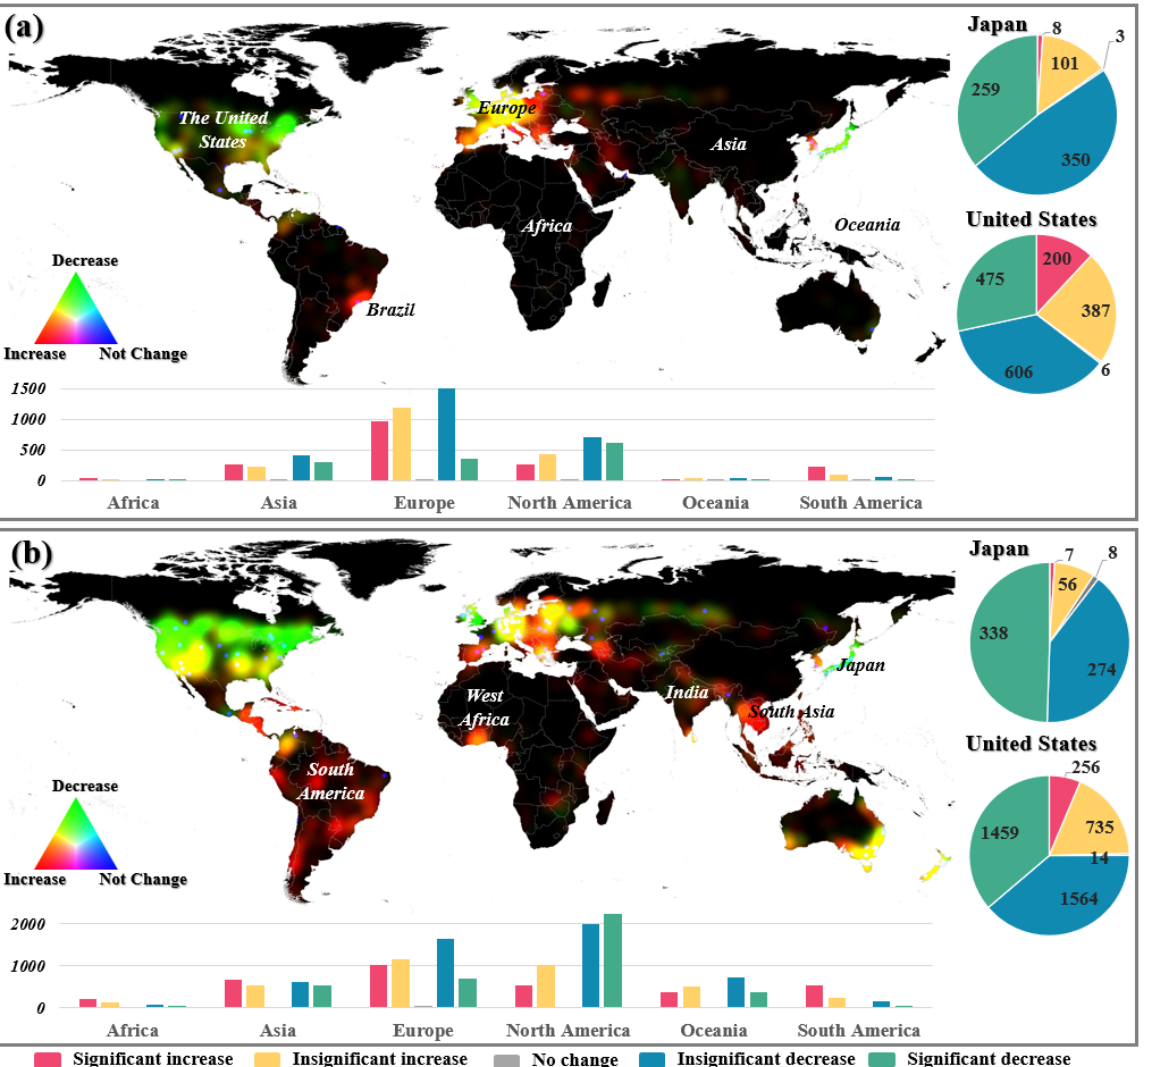
Figure 5. The temporal trends of NTL worldwide in continuously polluted ( a ) and discontinuously polluted ( b ) PAs. The visualization of kernel density maps is composited by channels of increase (R), decrease (G), and no change (B). Note: the search radius of the kernel density is 5 degrees, and the weight is the natural logarithm of the area.